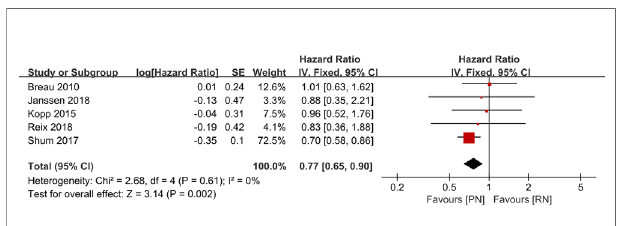
FIGURE 11 | Overall survival.